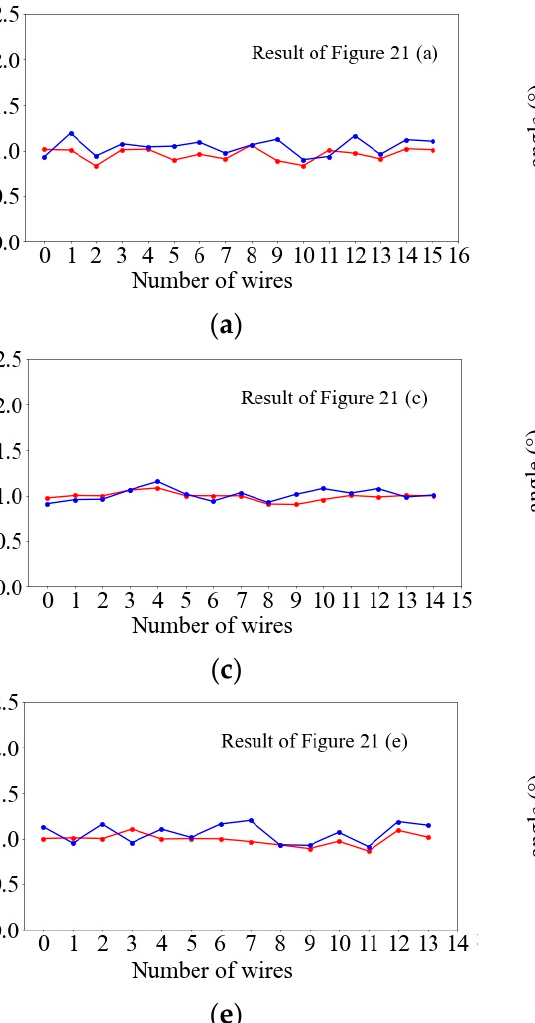
Figure 21. ROI images during production: ( a – d ) is the ROI of the 2.4 mm wire; ( e – h ) is the ROI of the 2.6 mm wire.